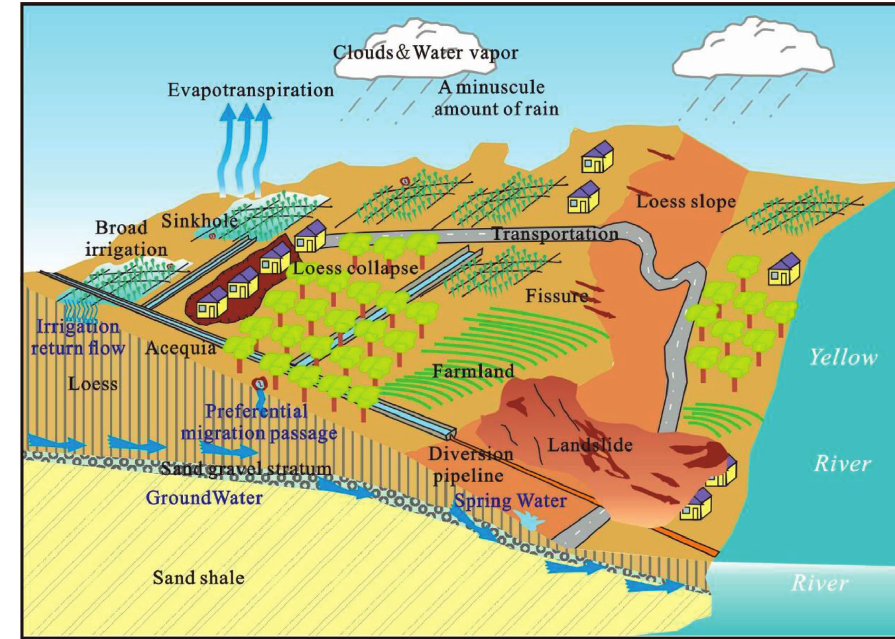
Figure 4: Irrigation water infiltration mode.